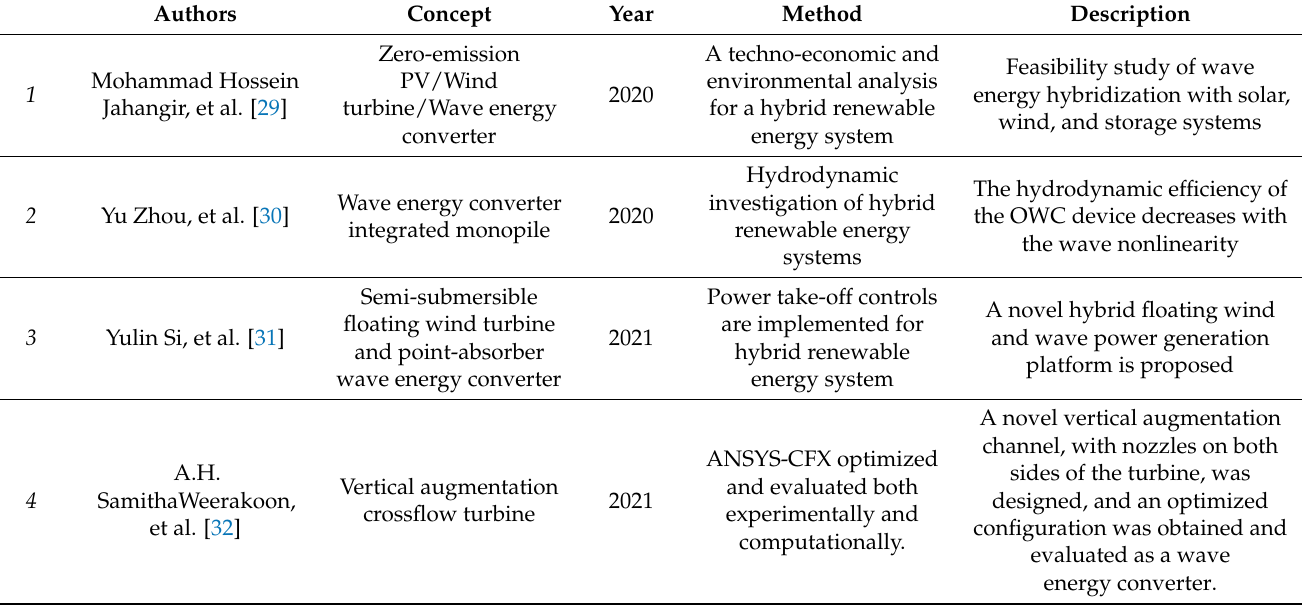
Table 1. Recent studies on hybrid RES sites by combining wave energy converter and wind